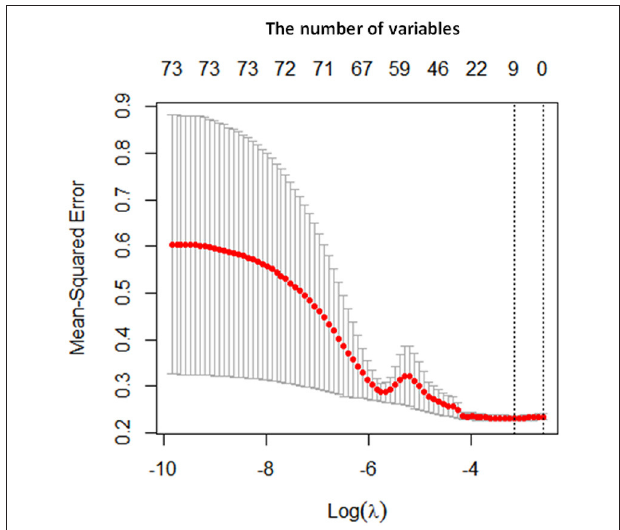
FIGURE 1 | Prediction variables identified by LASSO. The x axis represents the log value of lambda, and y axis represents the mean squared error. The first dotted line represents the minimum mean squared error, corresponding to the optimum number of variables. The number at the top of the picture represents the number of variables.